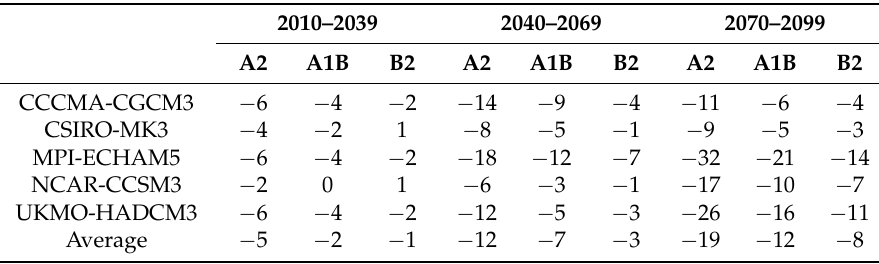
Table 5. Downscaling results for rainfall Zambezi Basin. Values in the table represent the Delta change (%) relative to reference period.